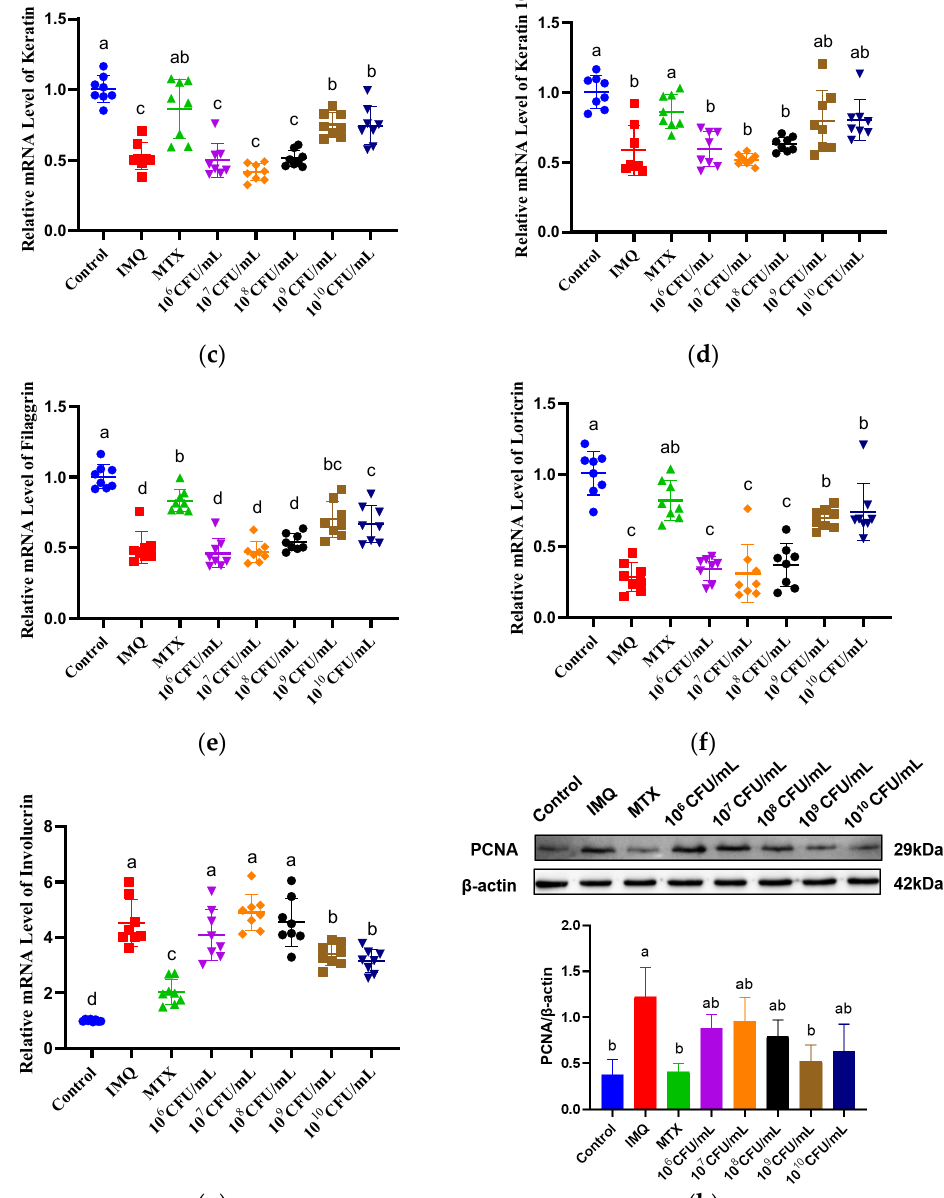
Figure 4. Effect of CCFM683 treatment on keratinocytes and epidermal barrier in psoriasis mice. Relative mRNA levels of ( a ) keratin 16, ( b ) keratin 17, ( c ) keratin 1, ( d ) keratin 10, ( e ) filaggrin, ( f ) loricrin, and ( g ) involucrin, and ( h ) protein levels of PCNA. n = 8 mice per group in mRNA determination and n = 3 mice per group for protein measurement. Groups with different letters are significantly ( p < 0.05) different from each other.